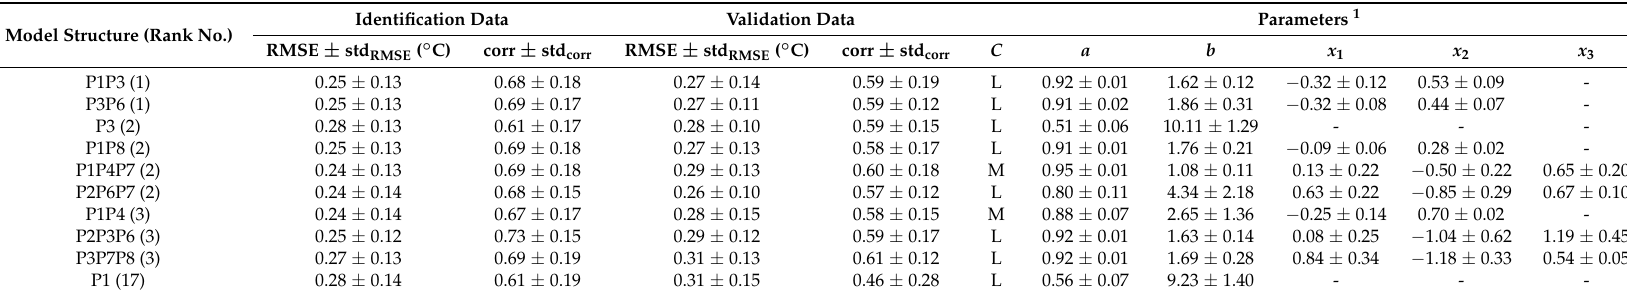
Table 6. Modelling results with mean RMSE and r and their standard deviation with five buildings. RMSE and r values were calculated by averaging the values of the four identification/validation data sets for every building and then calculating the mean using values of all five buildings. Model Structure (Rank